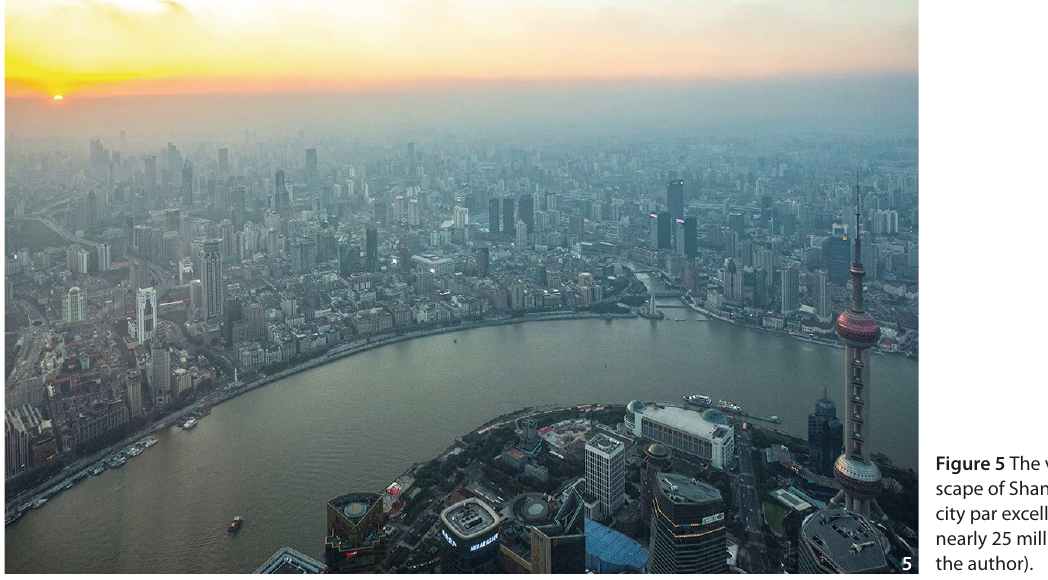
Figure 5 The vast urban land- scape of Shanghai, a modern city par excellence and home to nearly 25 million people (Source: the author).